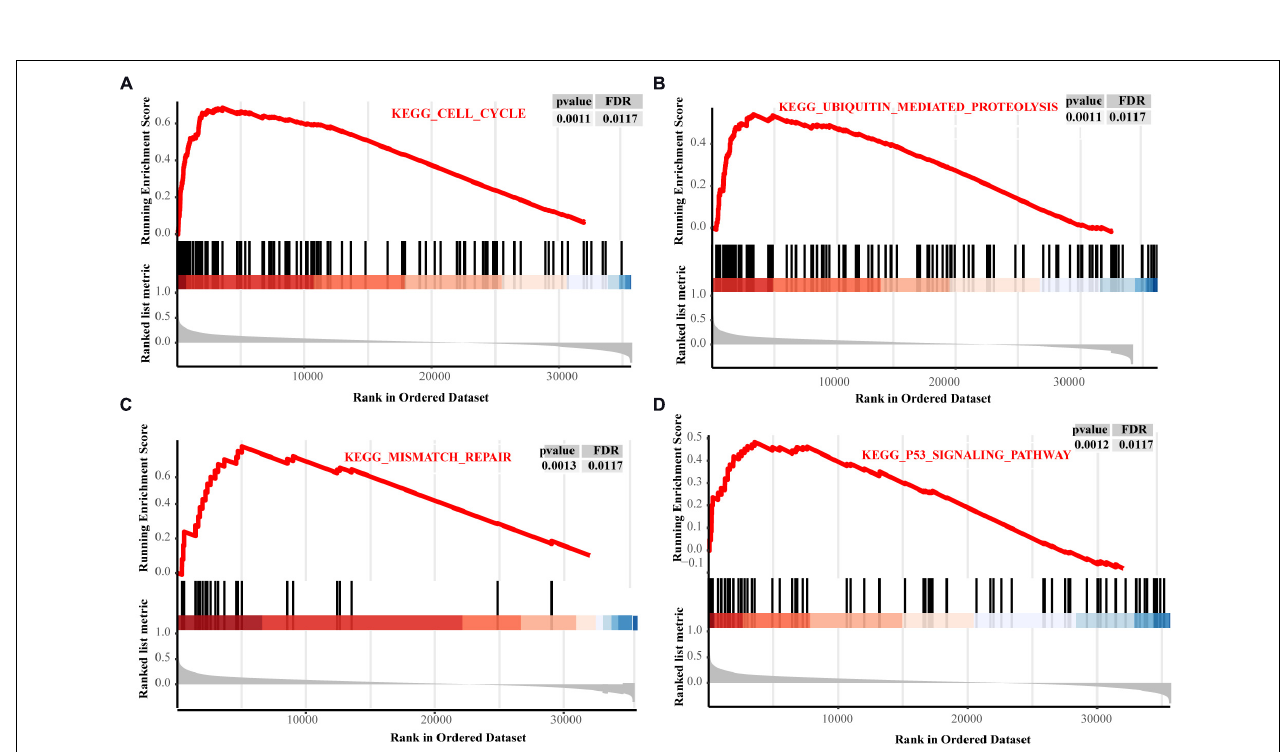
FIGURE 9 | The GSEA results about GNPNAT1 in LUAD from TCGA. The signaling pathways of the cell cycle (A) , ubiquitin mediated proteolysis (B) , mismatch repair (C) , and p53 signaling pathway (D) .